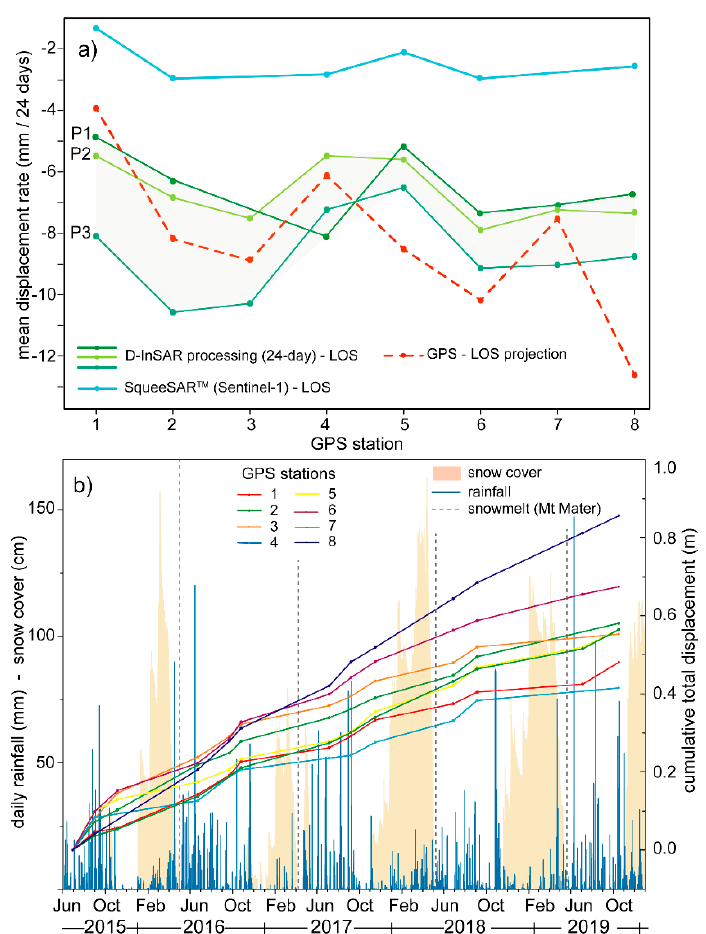
Figure 5. Spatial and temporal trends of activity from GPS and DInSAR data. ( a ) spatial trends of displacement rates derived from SqueeSAR TM , DInSAR and GPS data, extracted at GPS benchmark locations and scaled to a 24-day period. SqueeSAR TM data were processed over a 2-year acquisition period; GPS displacement rates are derived from cumulative displacements averaged over the 4-year observation period and projected along the Sentinel-1 LOS; DInSAR displacement rates were extracted from three unwrapped 24-day interferograms (P1: 14 / 06 / 2017–14 / 07 / 2017; P2: 02 / 07 / 2017–26 / 07 / 2017; P3: 12 / 09 / 2017–06 / 10 / 2017); ( b ) time series of cumulative GPS 3D displacements compared to daily rainfall and snow cover (data: ARPA Lombardia).